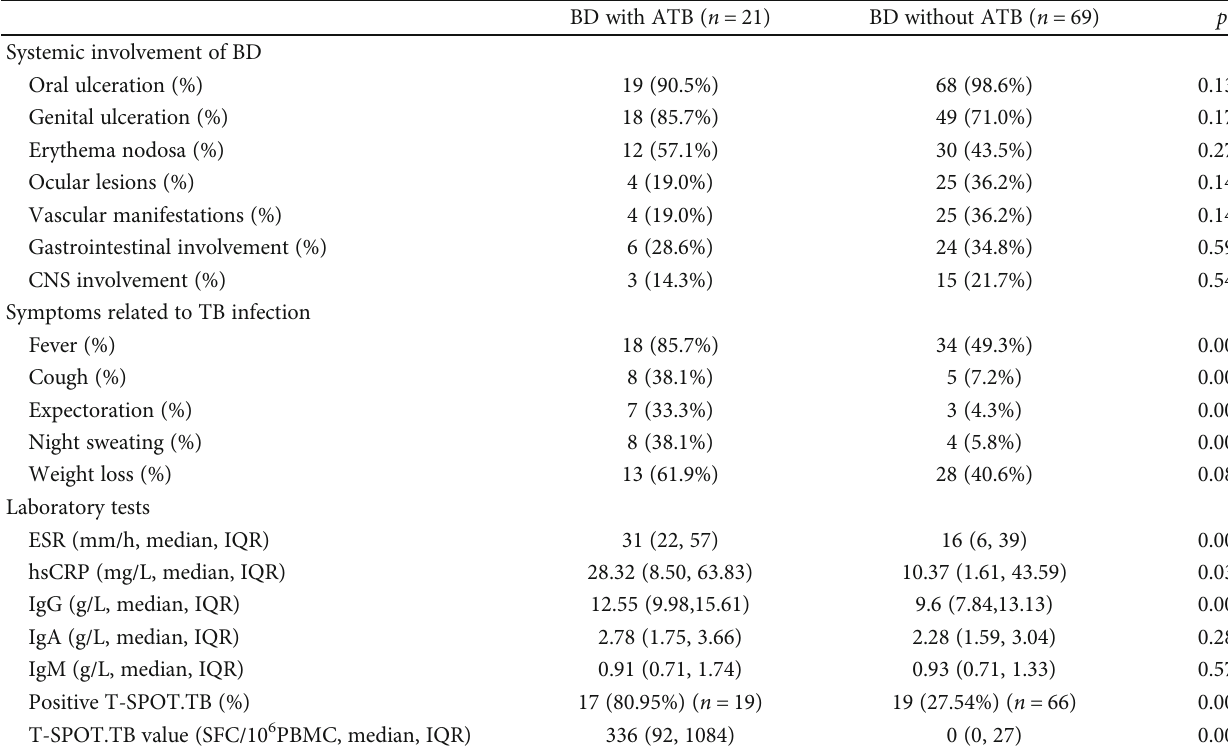
Table 2: Clinical presentation and laboratory results of BD patients with and without ATB.